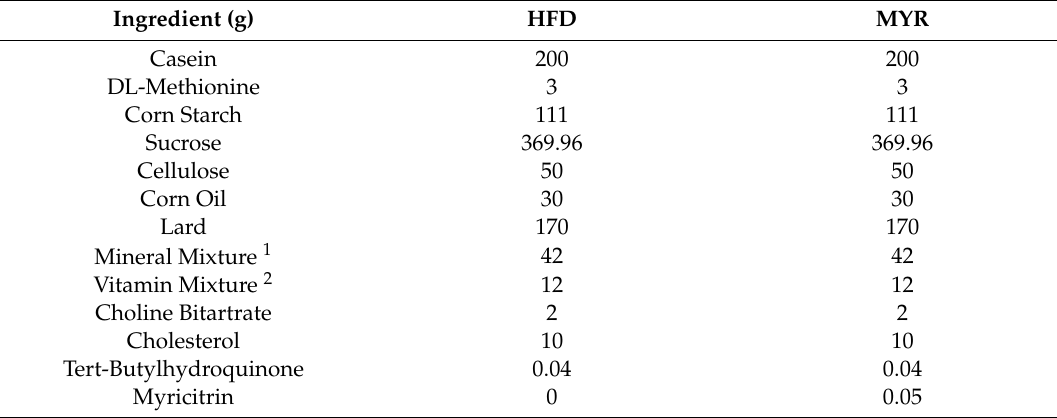
Table 1. Ingredient composition of the diets fed to mice (g kg − 1